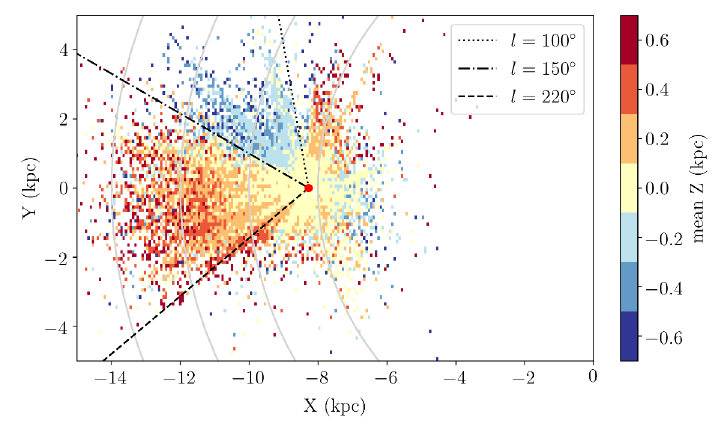
Figure 1. XY projection of OB stars in about 135 ◦ < φ < 225 ◦ . Four gray solid lines are R = 8 , 10 , 12 , and 14 kpc with mean Z as a color-code. Sun is presented by a red dot. Warp down and warp up region are selected in 100 ◦ < l < 150 ◦ and 150 ◦ < l < 220 ◦ ,